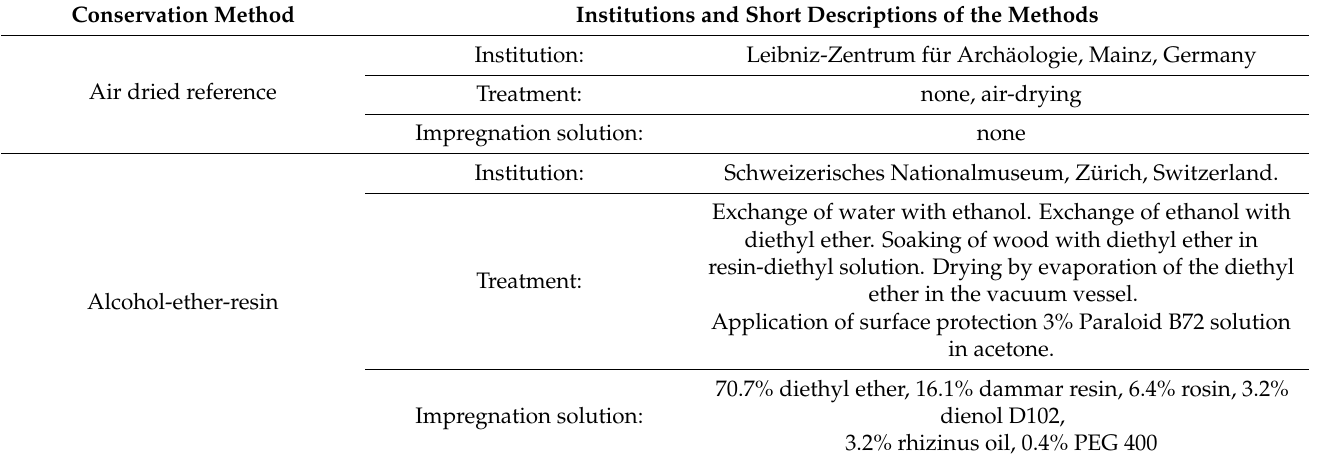
Table A1. Conservation methods and details